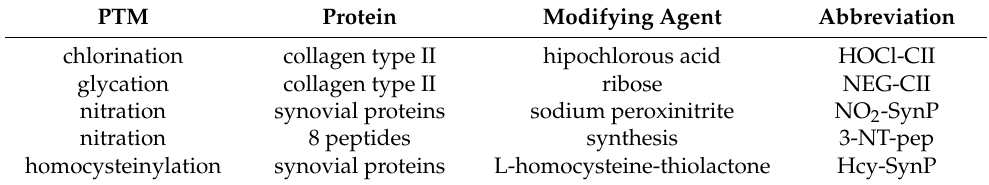
Table 2. Summary of the four analyzed